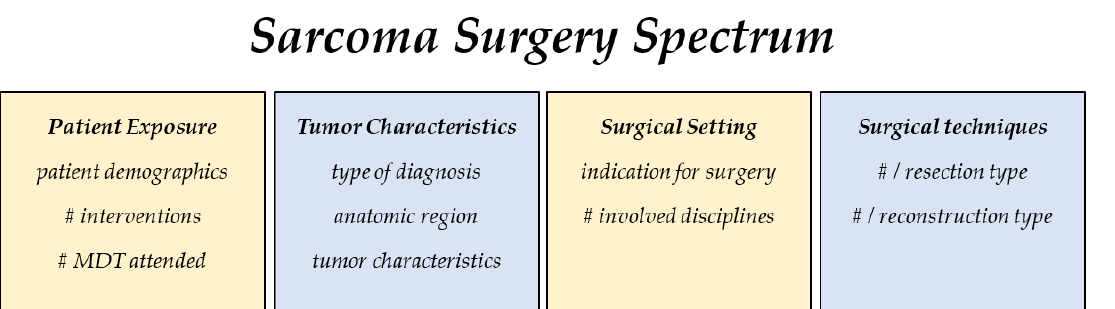
Figure 1. The exposure to sarcoma surgery is assessed in the following 4 categories: patient exposure, tumor characteristics, surgical setting, and surgical techniques applied. # number of.